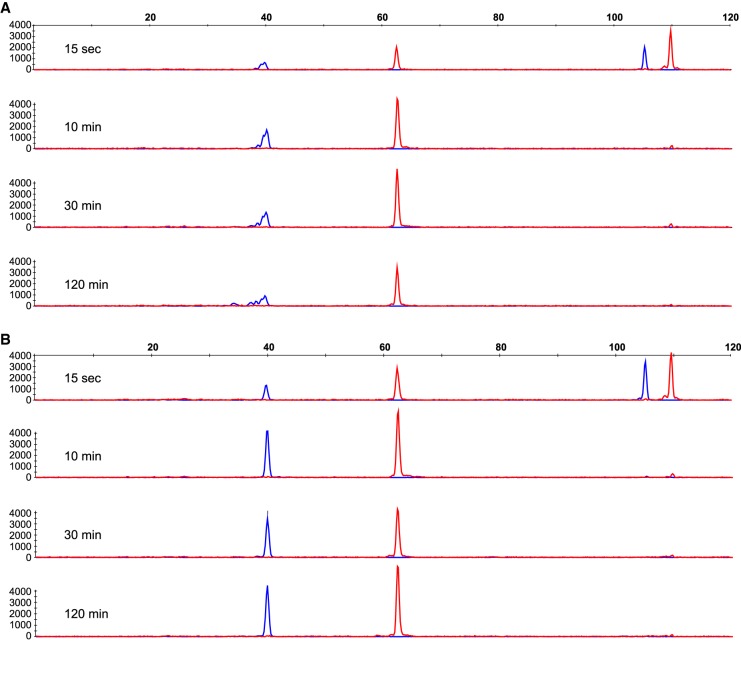
S. aureus Cas9 does not exhibit detectable post-cleavage trimming activity on cleaved DNA. (A,B) Representative capillary electrophoresis of 110mer DNA labeled with 5′-FAM (blue trace) on the PAM-containing strand and 5′-ROX (red trace) on the non-PAM strand hydrolyzed by (A) SpyCas9 or (B) SauCas9 at reaction time points of 15 sec, 10 min, 30 min, and 120 min. Data are plotted as relative fluorescence versus DNA oligomer length. The trend was consistently observed over the course of our experimentation (n > 10) with SpyCas9 and SauCas9.